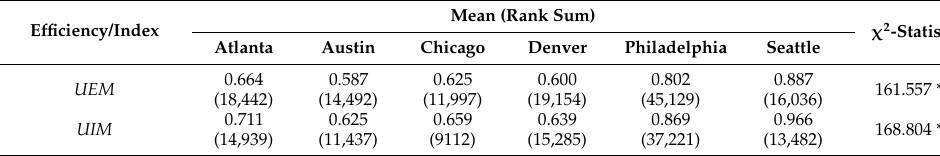
Table 10. Kruskal-Wallis Tests of States of EDA’s Six Different Regions.